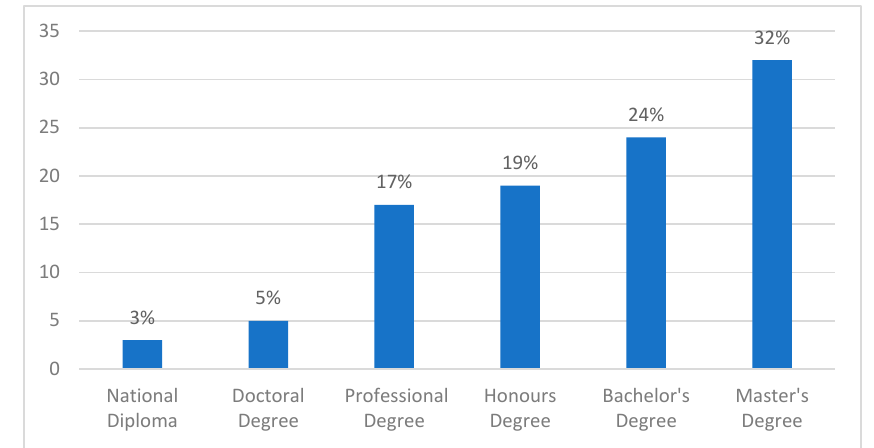
Figure 3. Respondents’ professional qualification.